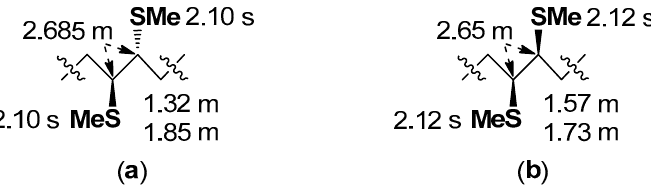
Figure 6. Some δ H values (700 MHz, CDCl 3 ) for the S -methylated substructures of ( a ) methyl threo-9,10-bis(methylthio)hexadecanoate and ( b ) methyl erythro-9,10-bis(methylthio)hexadecanoate. Unlike the signals of the methylthio groups of the threo-isomer, the signals of –SMe groups of the erythro-isomer were two partially resolved singlets at δ H 2.121 and 2.119.